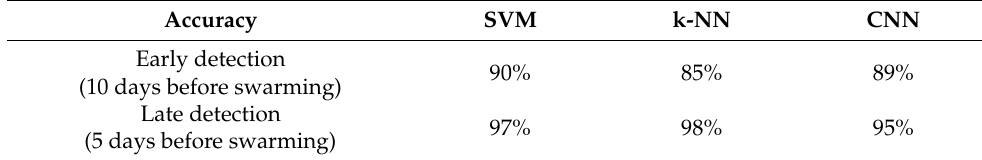
Table 13. Cross-comparison results of all three methods. Accuracy SVM k-NN CNN Early detection 90% 85% 89% (10 days before swarming) Late detection 97% 98% (5 days before swarming)